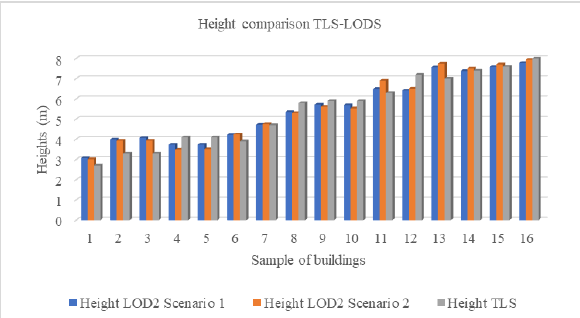
Figure 12. Comparison of heights between some TLS